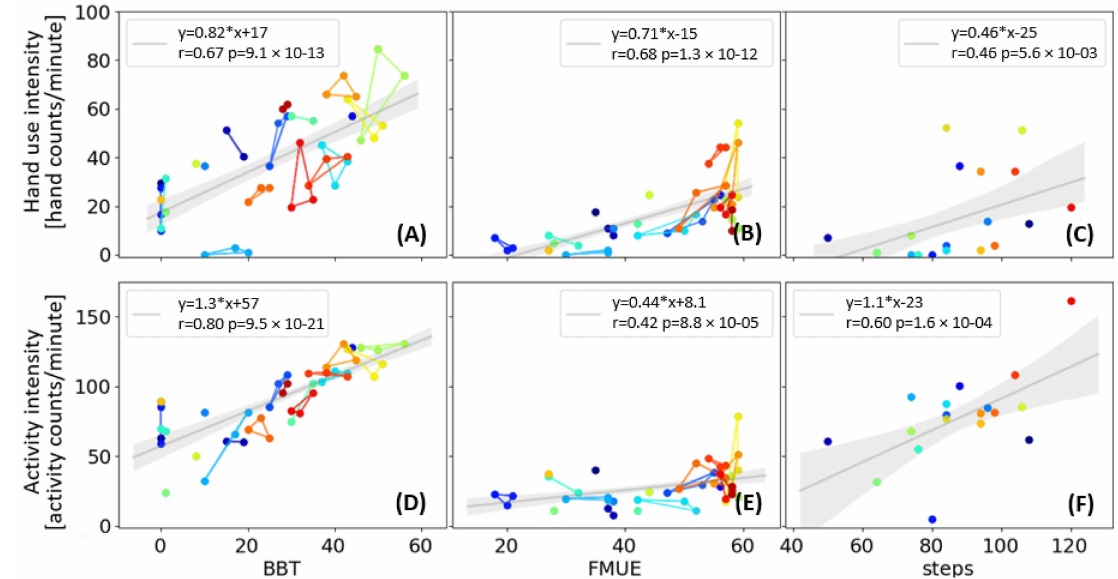
Figure 7. Hand use intensity and activity intensity ( from top to bottom ) during clinical tests (the Box and Blocks Test—BBT, the Fugl-Meyer Upper Extremity Assessment—FMUE, and the 1-minute walking test), ( from right to left ) performed in the lab. Linear fit is presented with the shaded area showing the 95% confidence interval. Each color (connected by lines) represents one subject, and each subject can have one to three samples for each